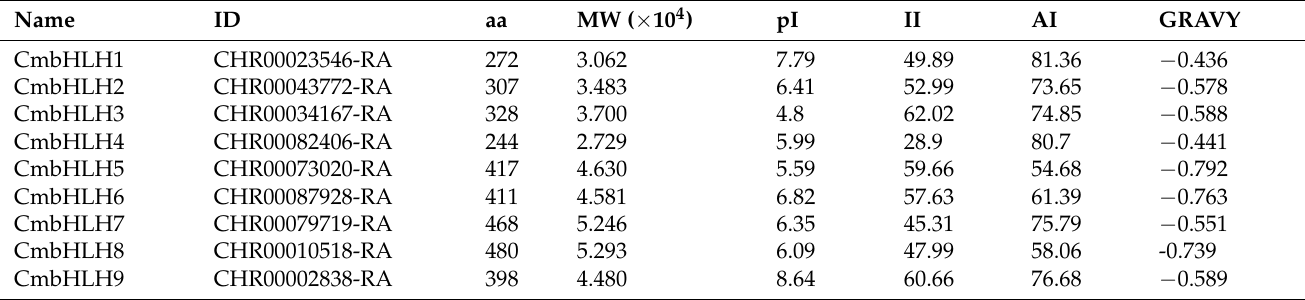
Table 1. Physiochemical properties of the CmbHLH TF